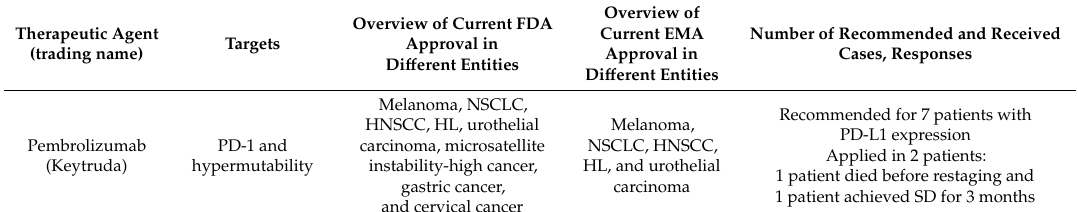
Table 4. Rationale for targeted therapy recommendations ( n =